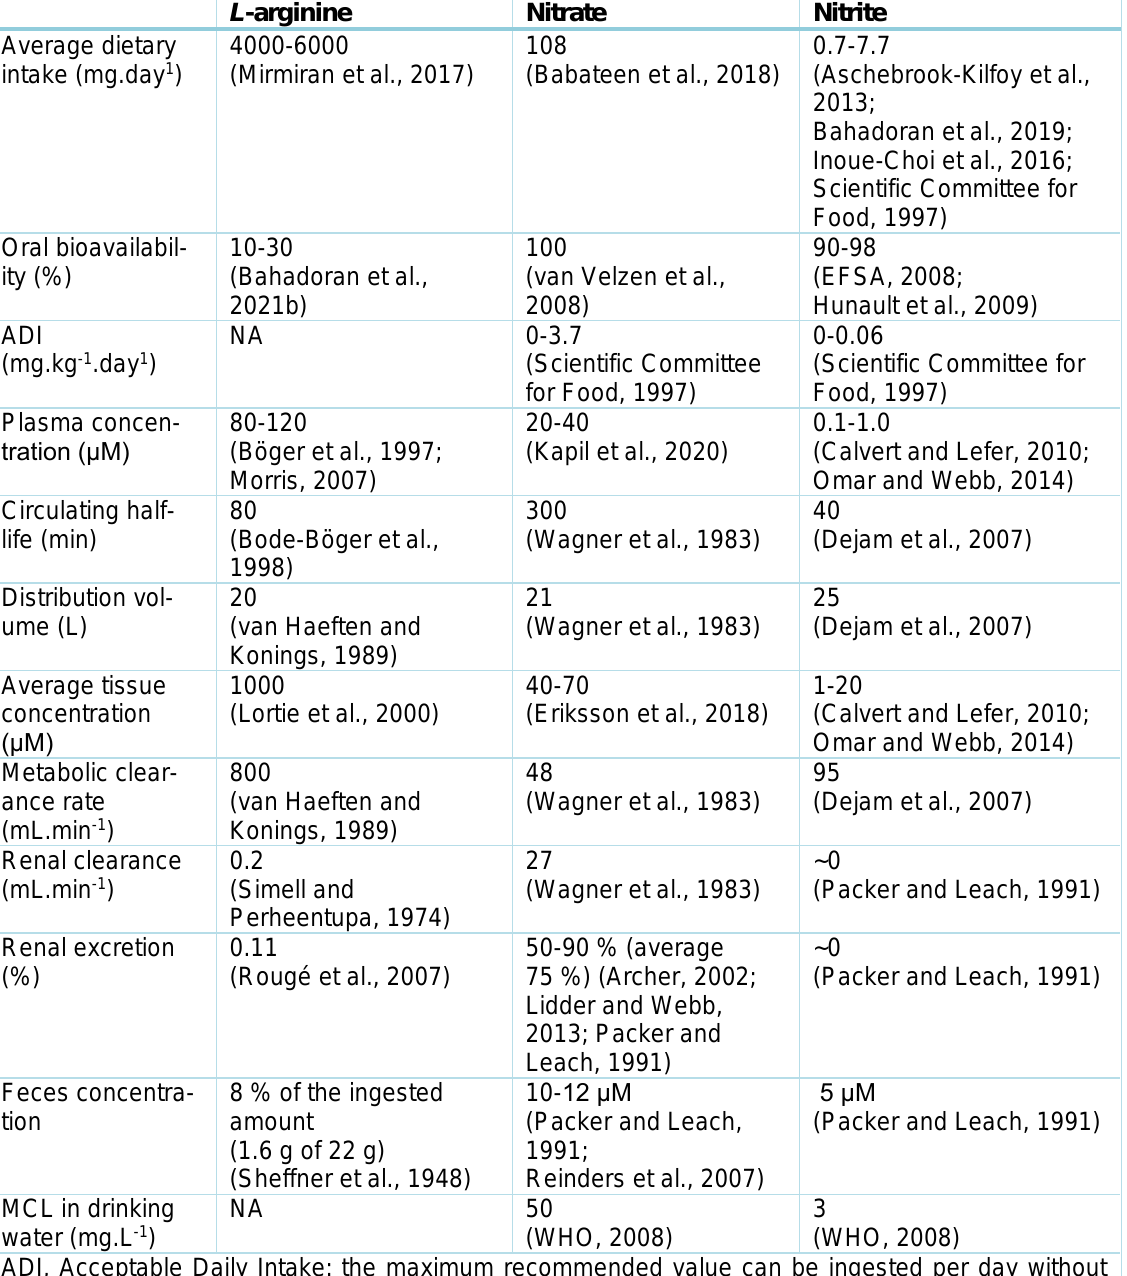
Table 1: Summarized data on L -arginine, nitrate, and nitrite